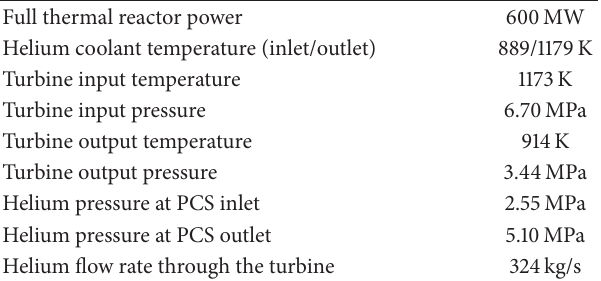
Table 3: Nuclear power plant with direct CBC, helium WF, and single-shaft turbo-machine